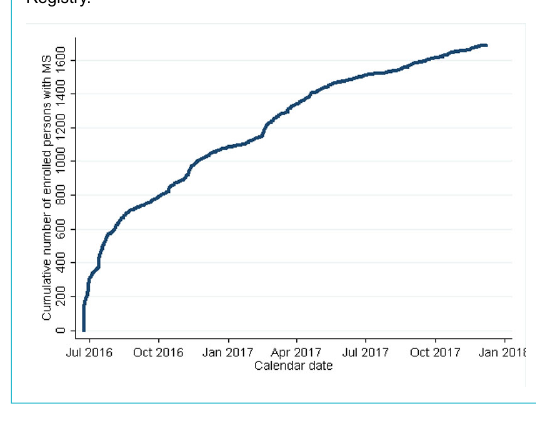
Figure 2: Cumulative enrolment of participants in the Swiss MS